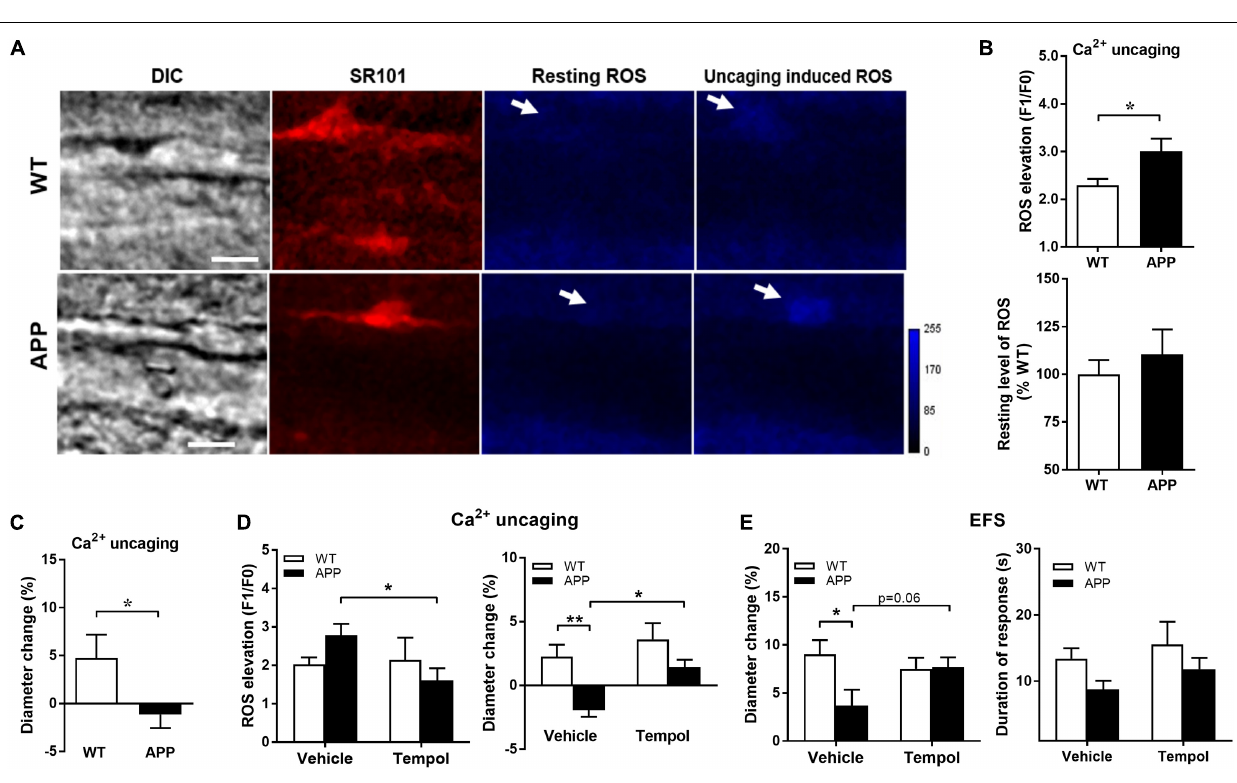
FIGURE 6 | Ca 2 + uncaging induces a higher level of ROS production in astrocytic endfeet in APP mice. (A) Representative images of infrared differential interference contrast (IR-DIC), SR101 (astrocytes), resting ROS and Ca 2 + uncaging induced ROS in brain slices from WT and APP mice. Arrows indicate targeted endfeet of Ca 2 + uncaging (Scale bars, 10 µ m). (B) Astrocytic endfeet ROS production and (C) vascular diameter after Ca 2 + uncaging in hippocampal slices from APP mice compared with WT (* p < 0.05; two-tailed unpaired t -test; n = 12–16). (D) Tempol, through reducing the Ca 2 + uncaging-induced astrocytic ROS production (left panel), prevented the impaired vascular response to Ca 2 + uncaging (right panel) in APP mice (* p < 0.05; ** p < 0.01; two-way ANOVA followed by Bonferroni correction, n = 9–15). (E) Tempol also prevented the reduced vascular responses to EFS (left panel) without modifying the duration of the response (right panel) (* p < 0.05; two-way ANOVA followed by Bonferroni correction, n =